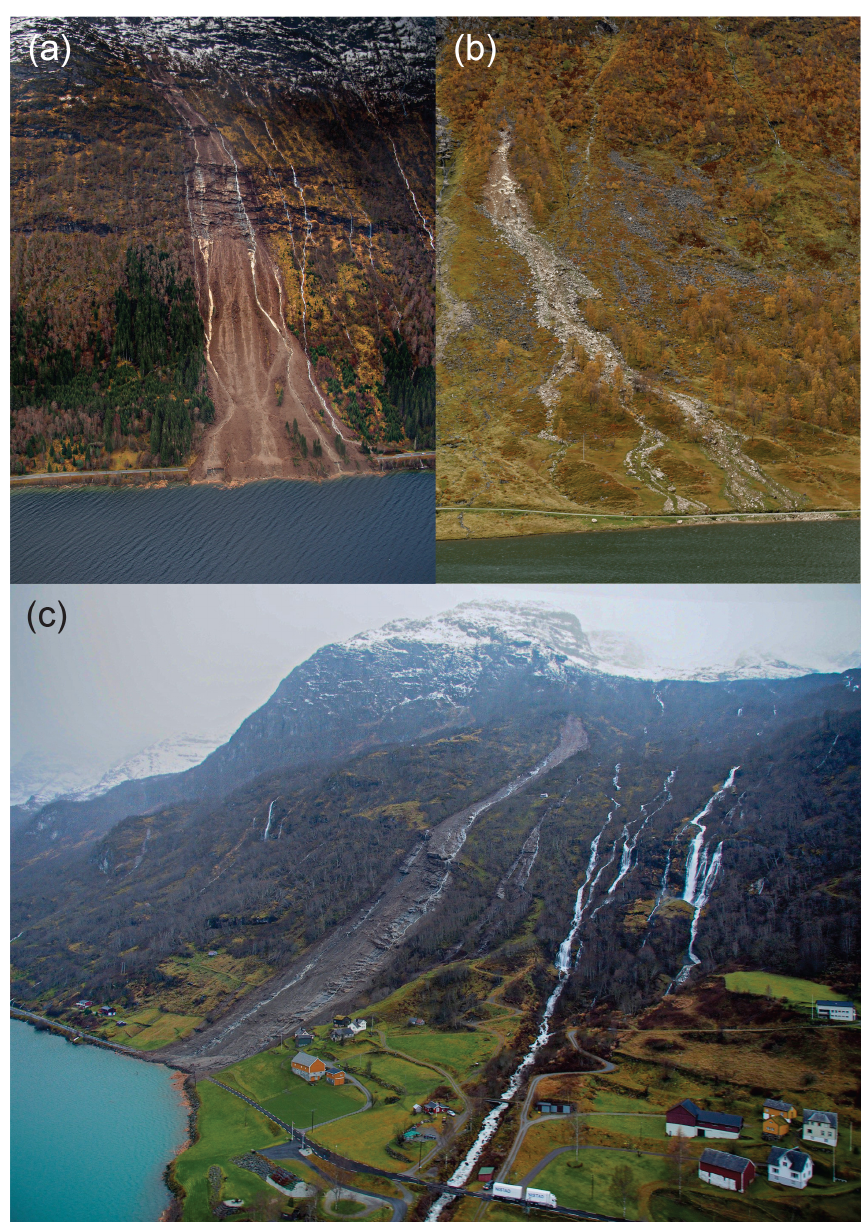
Figure 2. Photos of landslides that occurred during storm Hilde in 2013; see Table 1 for details. (a) Skredestranda, photo: Jan Helge Aalbu, 16 November 2013. (b) Anestølen, this study, photo: Kevin Saurin, 6 October 2014. (c) Oldedalen at Yri, photo: Jan Helge Aalbu, 16 November 2013. titude (station 55730; data downloaded from